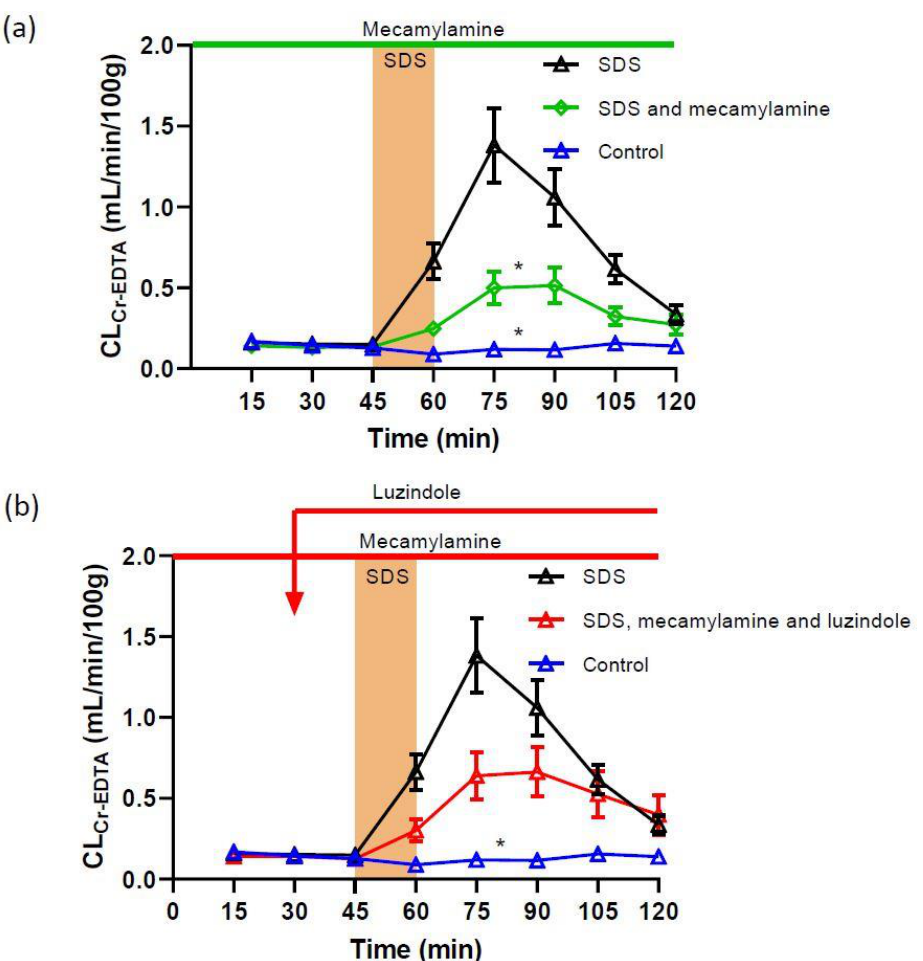
Figure 2. Effect of 5 mg/mL SDS in the luminal perfusate, between 45 and 60 min, on jejunal paracellular permeability (blood-to-lumen 51 Cr-EDTA clearance (CL Cr-EDTA )). ( a ) Adding the non-selective, non-competitive nicotinic acetylcholine receptor antagonist mecamylamine to the luminal perfusate at 100 µM strongly reduced the SDS-induced increase in permeability. ( b ) Adding luzindole (melatonin receptor antagonist) at 100 µM did not alter the effect of mecamylamine. Values are means (±SEM). * significantly ( p < 0.05) lower response compared with the SDS group.